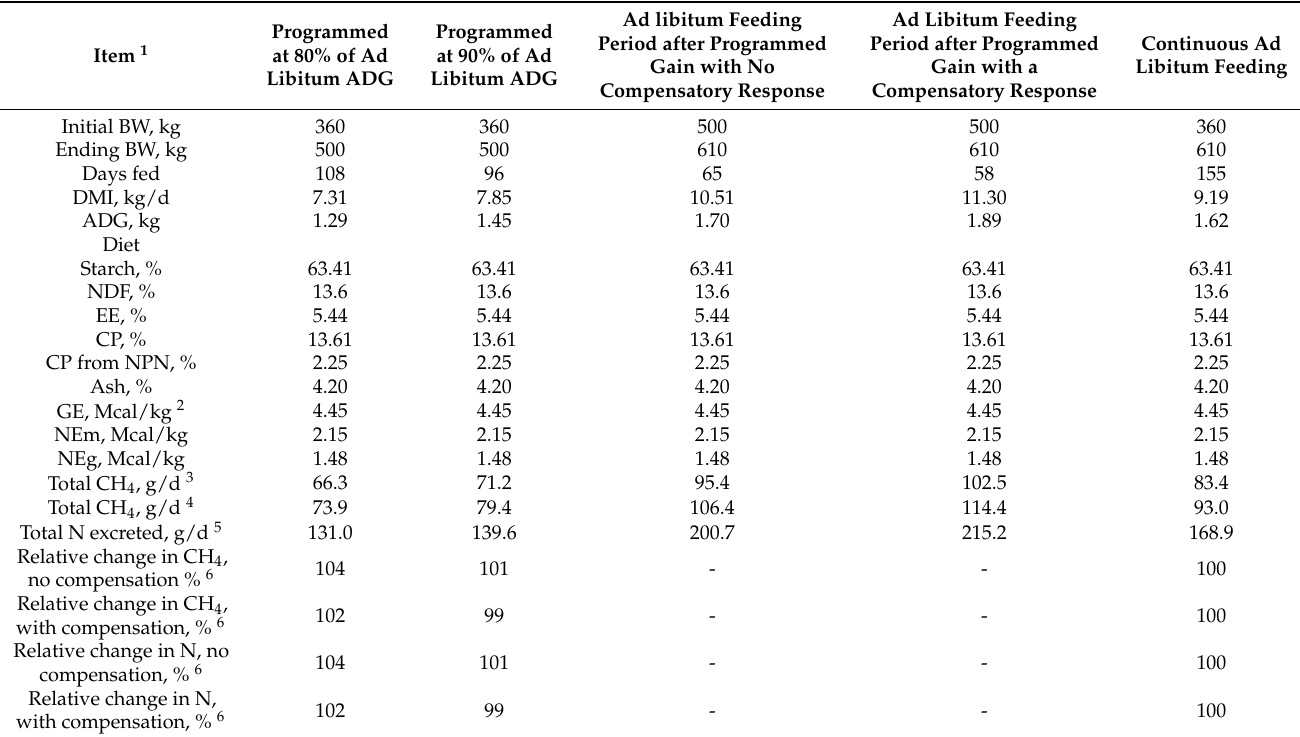
Table 2. Effects of programmed feeding a high-concentrate diet at two different rates of gain followed by an ad libitum finishing period vs. continuous ad libitum feeding on estimated enteric emission of methane and excretion of nitrogen in feedlot beef